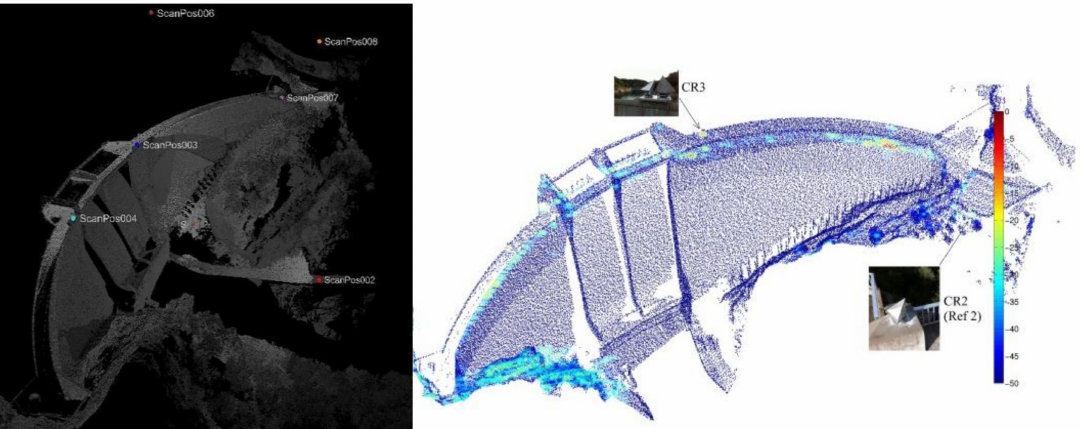
Figure 5. Integration of a point cloud from TLS surveying and results from DInSAR analysis with the aim of a better visualization and localization of displacement vectors (image credit: Anghel 2016